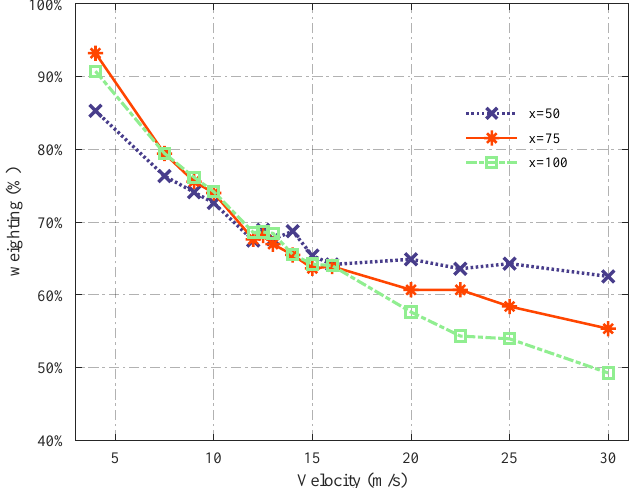
Figure 10. Percentage of particle mass within a height of 0 to 3 m.